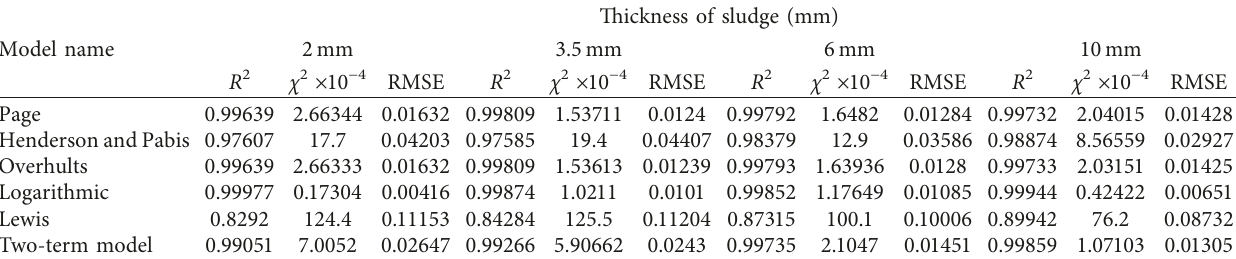
Table 6: Fitting results of drying stage of sludge superheated steam drying under different thickness of